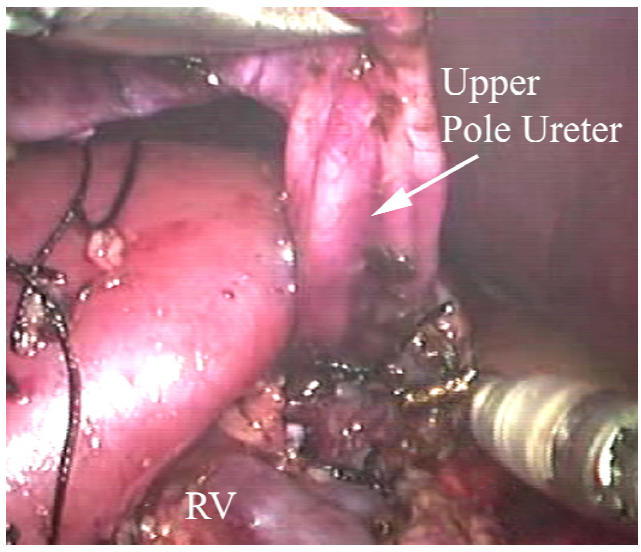
FIGURE 2. Development of the plane between the upper and lower poles during a robotically assisted, upper pole, partial nephrectomy for a nonfunctioning, upper pole associated with a ureterocele. The upper pole ureter has been transected, passed beneath the hilar vessles, and is used as a handle to dissect between the poles, avoiding entry into the lower and upper collecting systems. Vascular control of the upper pole has already been